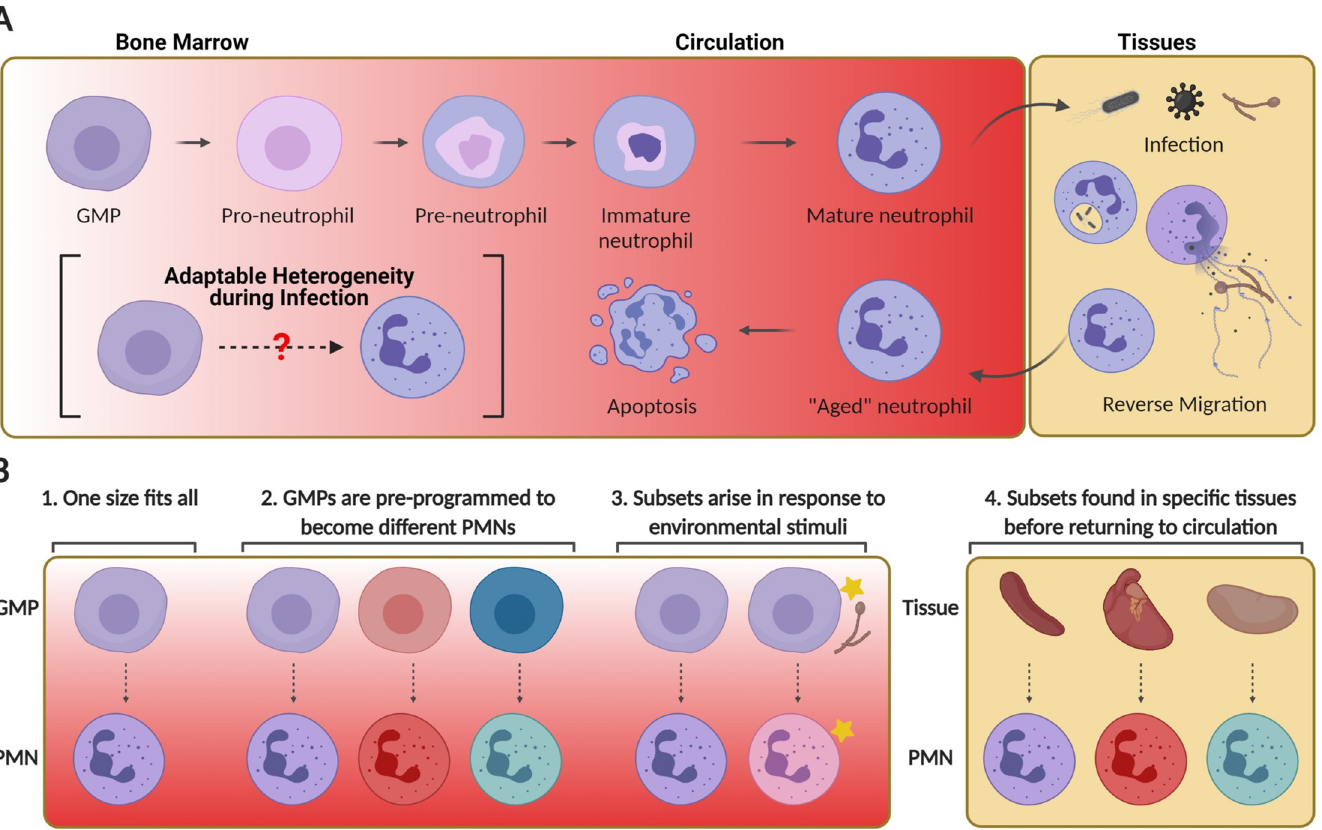
Fig 1. Schematic of proposed areas of neutrophil heterogeneity. (A) GMPs proliferate in the bone marrow after which they mature in circulation (bloodstream), and mature neutrophils hone to specific tissues or remain in circulation. (B) Potential areas for neutrophils to sort into separate subpopulations of cells. Created with BioRender.com. GMP, granulocyte monocyte progenitor; PMN, polymorphonuclear leukocyte.